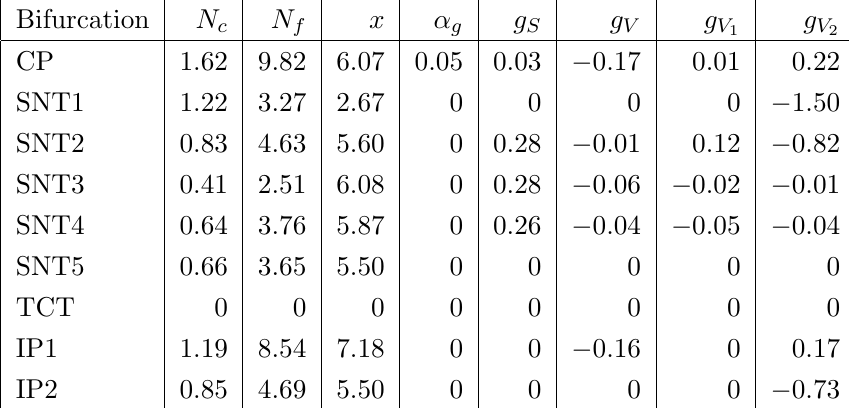
4 (2.9) with e(cid:11)ective four-fermi